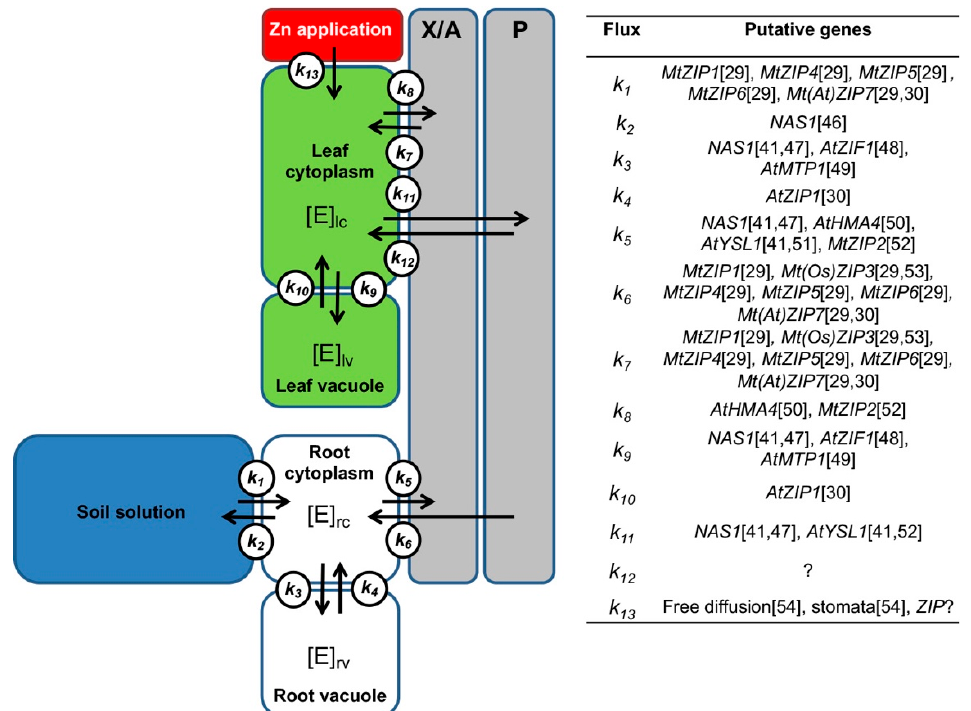
Figure 1. Suggested model for roles of putative genes encoding proteins involved in Zn transport- related processes. The sites of action in the plant (i.e., root cytoplasm, rc; root vacuole, rv; xylem and apoplast, X/A; phloem, P; leaf cytoplasm, lc; leaf vacuole, lv) and the element (E) fluxes (K 1–13 ) are reported. The concentration of the element is indicated in each site [E]. The scheme synthetizes information across studies in various plants. Gene abbreviations: ZIP , Zrt-/Irt-like protein; NAS , nicotianamine synthase; ZIF , zinc-induced facilitator; MTP , metal transporter protein; HMA , P1B-type heavy metal ATPase; YSL , yellow stripe like protein; ZIP ? indicates a generic ZIP ; free diffusion: diffusion through leaf epidermis; stomata: absorption through stomata. Plant abbreviations: Mt, Medicago truncatula ; At, Arabidopsis thaliana ; Os, Oryza sativa . References: [29,30,41,46–54].